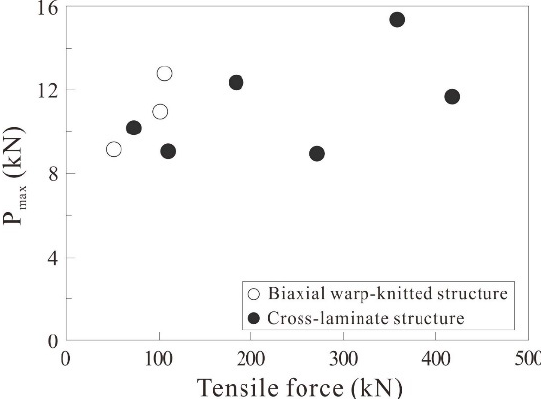
Figure 15. Relationship between carbon grid tensile force and maximum load.